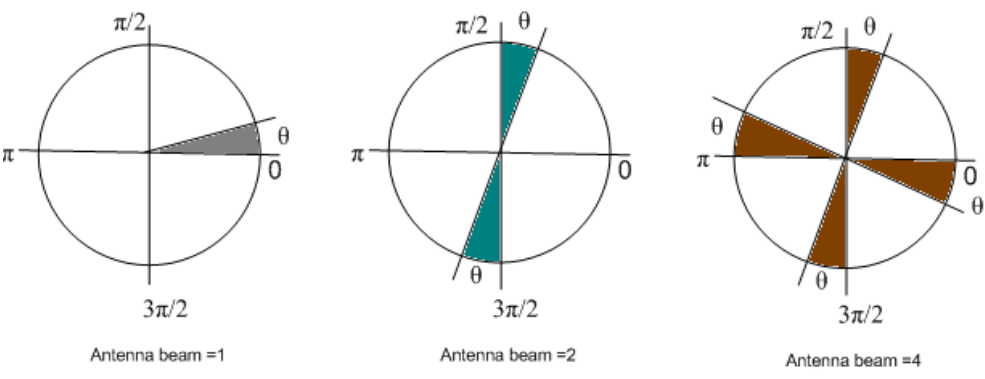
Figure 2. Beam pattern of antenna